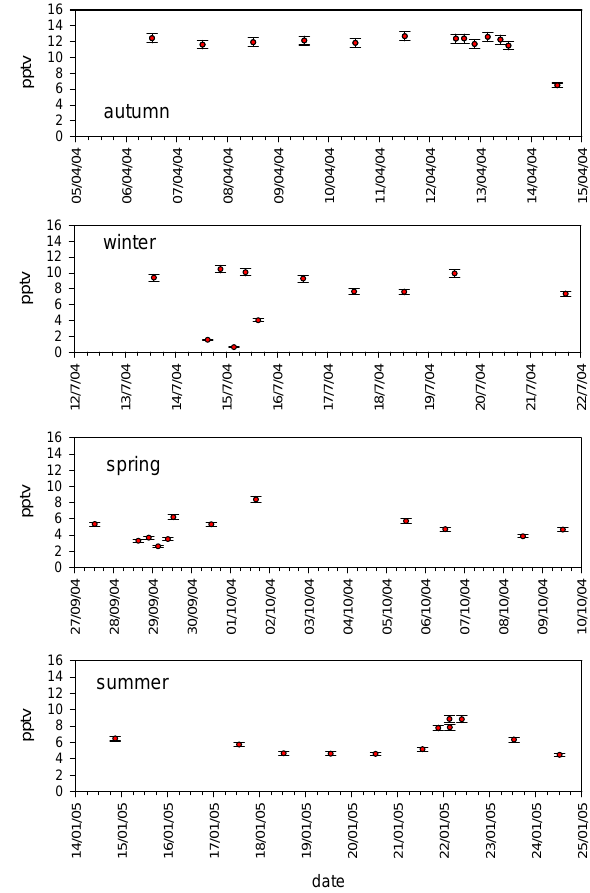
Fig. 2. Higher resolution (roughly daily or 6-hourly) flask sampling for methyl nitrate during each season. Data are irregular at times when inclement weather prevented